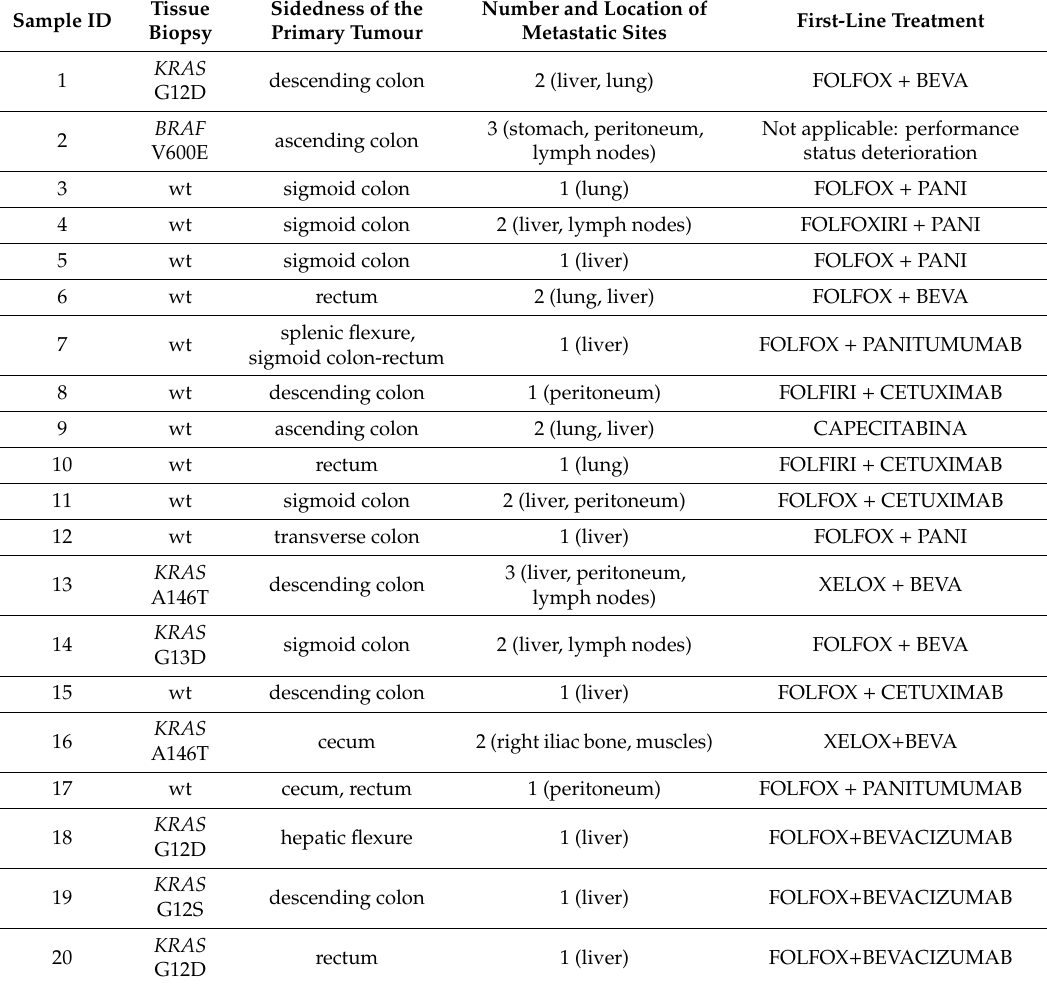
Table 1. Clinical data of the patients enrolled in the study.